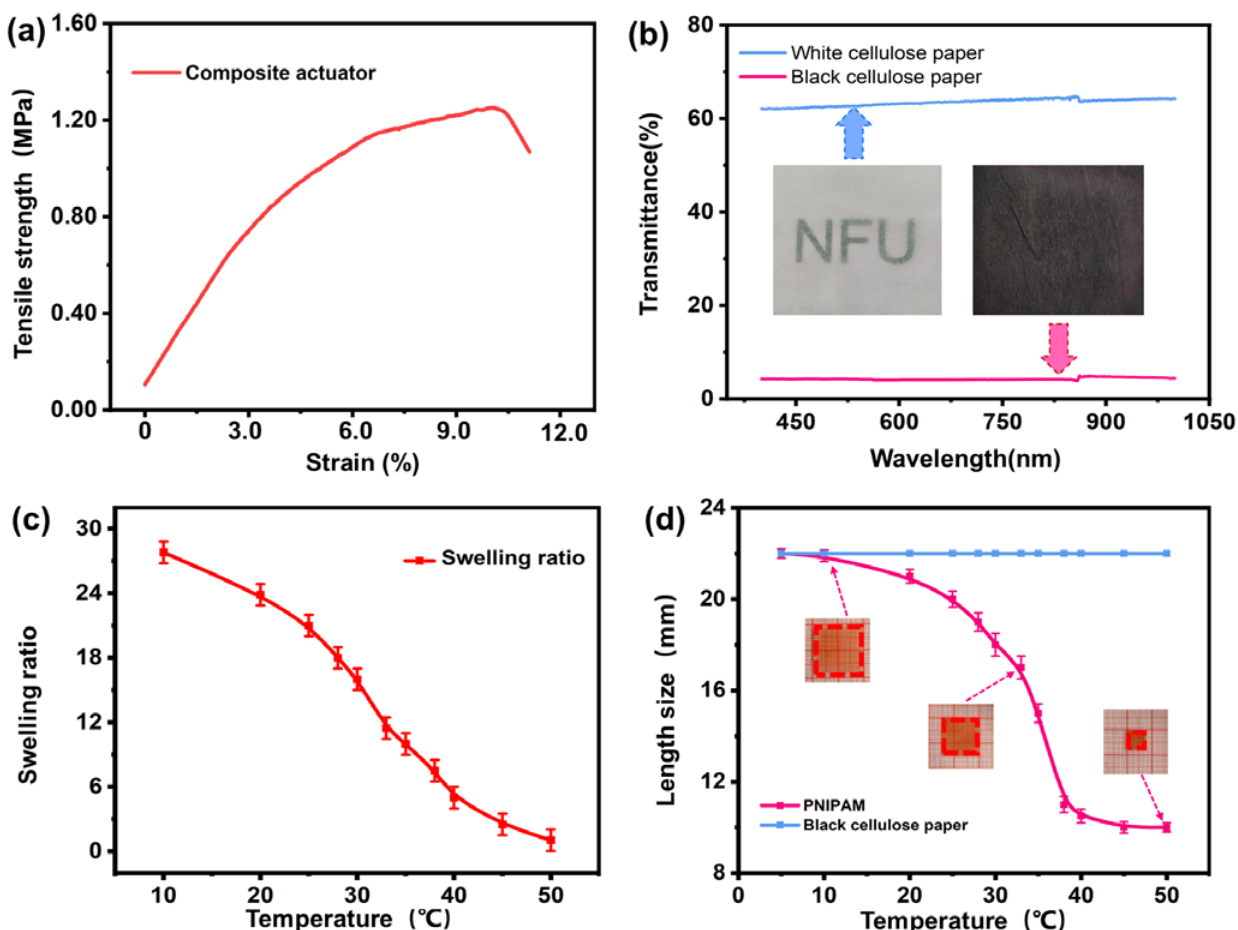
Figure 3. ( a ) The mechanical property of the tissue paper/PNIPAM hydrogel composite actuator. ( b ) Comparison of the light transmittance between the original tissue paper and the black tissue paper dyed by the printer. The ( c ) equilibrium swelling rate and the ( d ) length of the PNIPAM hydrogel at the temperature range from 5 to 50 °C.